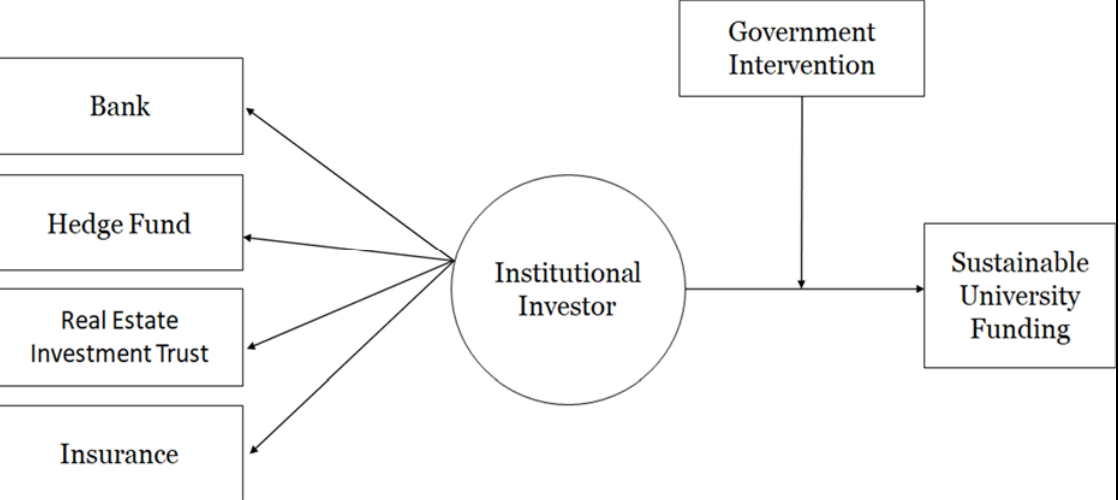
Figure 8. Moderation of Government Intervention in Institutional Investor & Sustainable University Sustainable Funding.